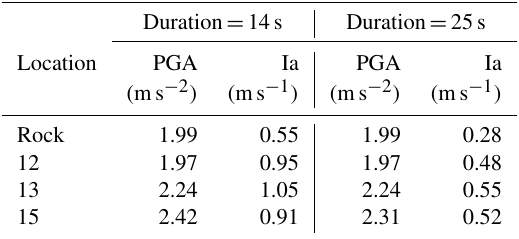
Table 4. PGA and Ia measured along the profile for the 14 and 25s in the bedrock, in the upper block (point 12), in the middle block (point 13) and in the lower block (point